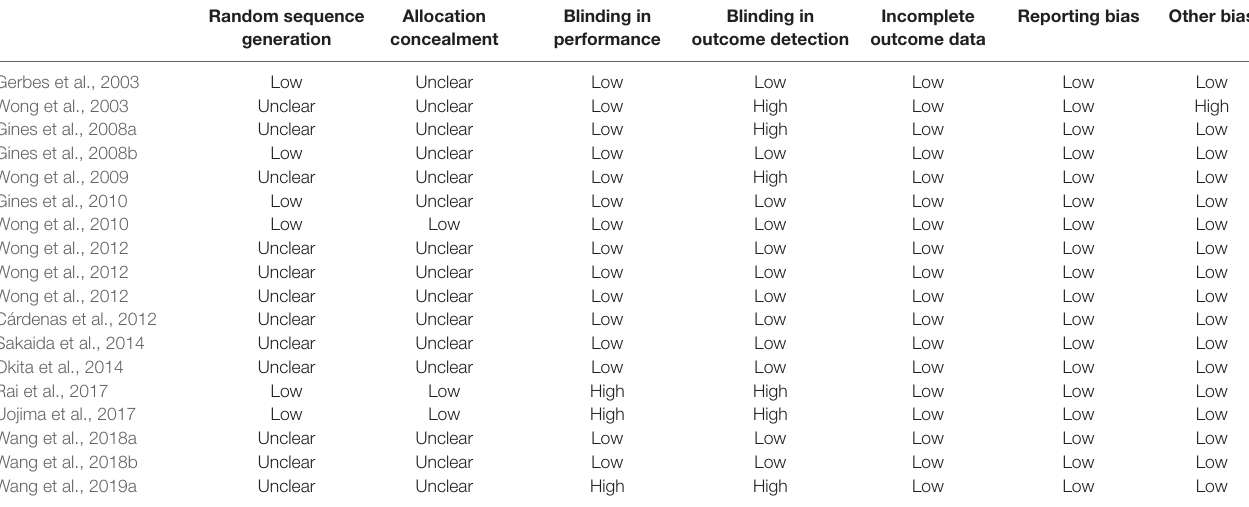
TABLe 2 | Study quality evaluation via Cochrane’s risk of bias